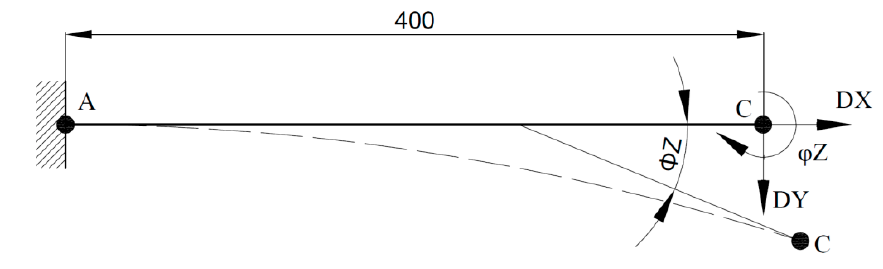
Figure 6. ANSYS submodel. Figure 6. ANSYS